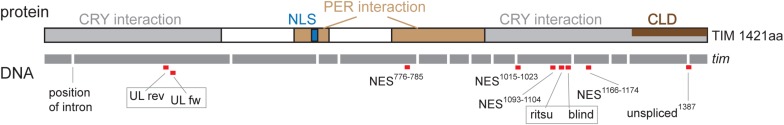
Schematic depiction of TIM protein with highlighted functional domains and interacting regions: nuclear localization signal (NLS), PERIOD interacting domain (PER interaction), CRYPTOCHROME interacting domain (CRY interaction), and cytoplasmic localization domain (CLD). Below, schematic depiction of DNA is shown with exons in gray (length of the bar corresponds to exon length) separated by introns (the length is not shown). Red boxes indicate position of gRNA; the number in gRNA corresponds to amino acid residues in the TIM protein. Gray frame indicates when two gRNAs were used simultaneously in one construct (UL rev + UL fw; ritsu + blind).